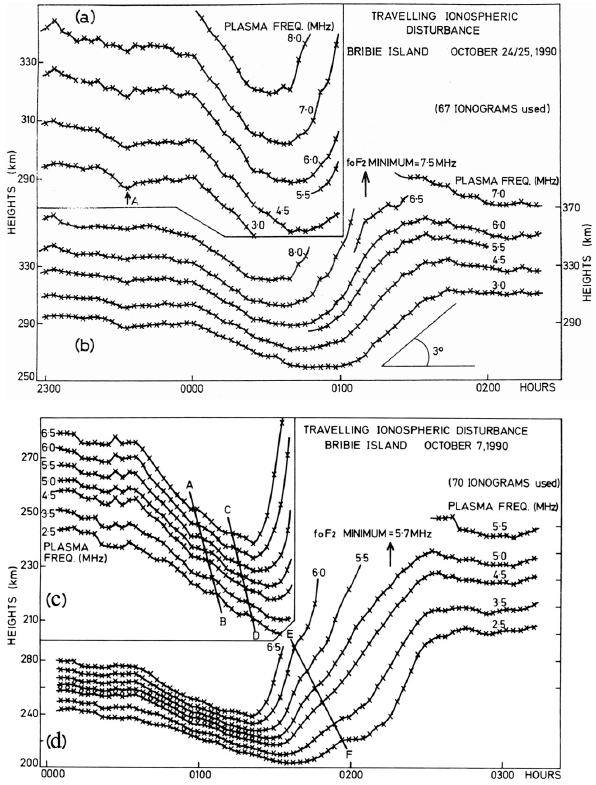
Fig. 2. Reproductions of LS-TID induced F 2 layer changes from (a) , (b) Fig. 5 of Bowman (1992) and (c) , (d) Fig. 19 of Bow- man (1992).